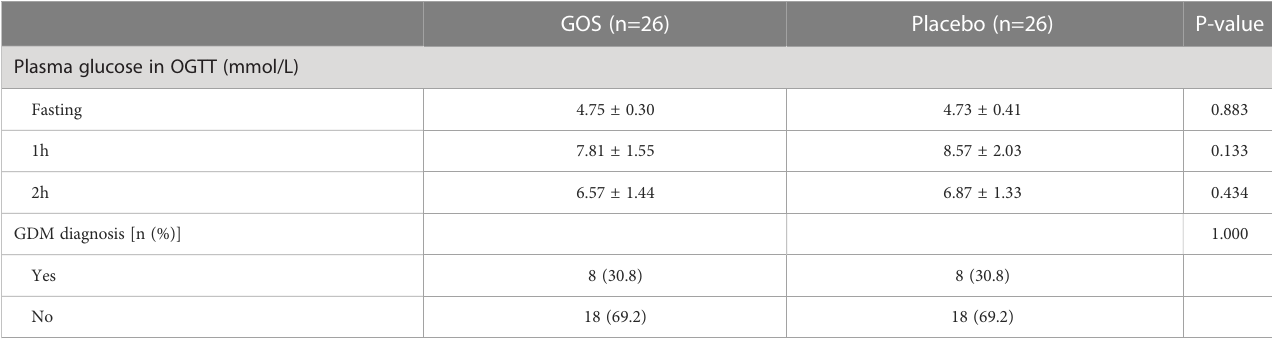
TABLE 2 GDM diagnosis and OGTT